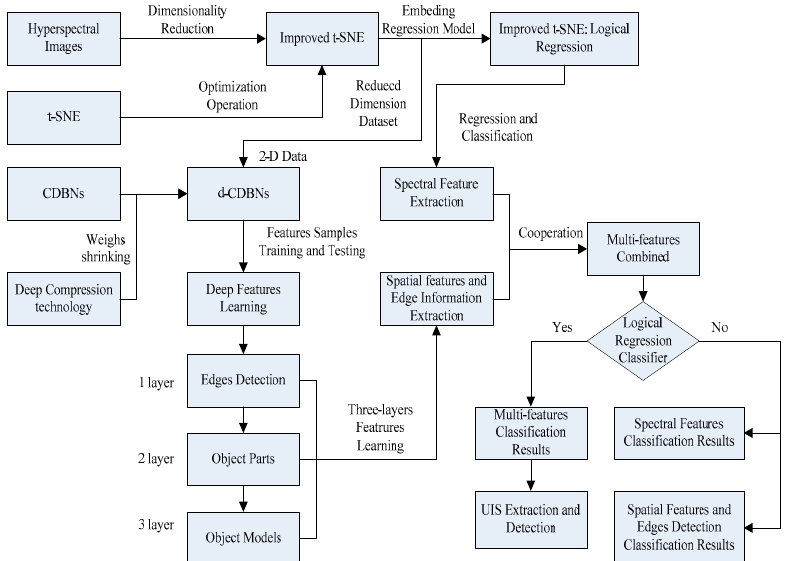
Figure 6. Framework of the MFEM model.